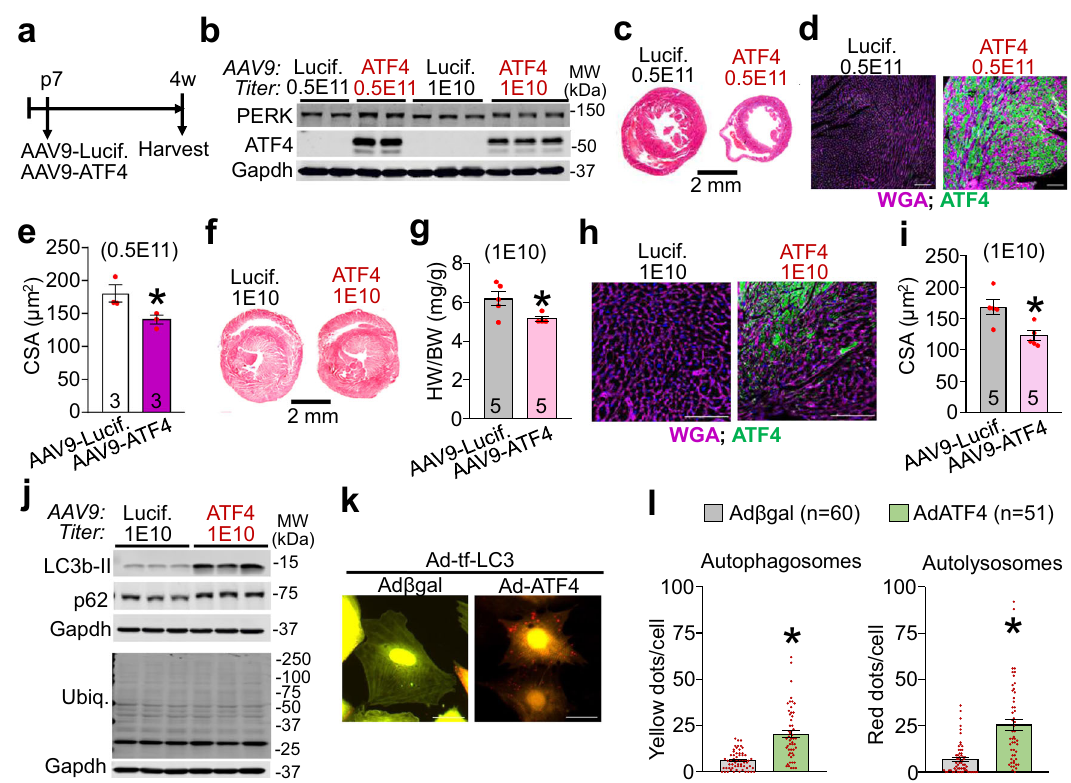
Fig. 9 ATF4 is suf fi cient to induce cardiac atrophy. a Schematic diagram depicting the experimental protocol. Either 0.5E11 or 1E10 genomic copies (gc) of AAV9-ATF4 or AAV9-Lucif. control were injected into the mediastinum of 7-day-old wild-type mouse pups. Hearts were harvested at 4 weeks of age for further analysis. b Representative western blots for PERK and ATF4 from cardiac protein extracts of 4-week-old mice treated with the indicated AAV9. Gapdh serves as a loading control. c , d Representative heart sections with Masson ’ s Trichrome staining ( c ) and immunohistochemistry for ATF4 (green) and WGA (purple)-stained membranes and nuclei with DAPI (blue) ( d ) of AAV9-ATF4 or AAV9-Lucif. injected mice (both 0.5E11 gc) at 4 weeks of age. Scale bars are 2 mm and 100 μ m, respectively. e CSA of AAV9-Lucif. versus AAV9-ATF4 positive cardiomyocytes determined by ATF4 and WGA staining of histological sections as shown in panel “ d ” . * P = 0.0548 vs AAV9-Lucif. f Representative Masson ’ s trichrome stained images of hearts from mice injected with 1E10 gc AAV9-Lucif or -ATF4 and harvested at 4 weeks of age. Scale bar is 2 mm. g HW/BW ratio at 4 weeks of age in the indicated groups of mice. * P = 0.0235 vs AAV9-Lucif. h Representative immunohistochemistry for ATF4 (green), nuclei with DAPI (blue) and WGA (purple)-stained membranes from heart sections of AAV9-ATF4 or AAV9-Lucif. injected mice (both 1E10 gc) at 4 weeks of age. Scale bars are 100 μ m. i CSA of ATF4 positive cardiomyocytes determined by ATF4 and WGA staining as shown in panel “ h ” . * P = 0.0116 vs AAV9-Lucif. j Representative western blots for LC3b, p62, and ubiquitin-conjugated proteins (Ubiq.) from cardiac protein extracts of 4-week-old mice treated with 1E10 gc AAV9-Lucif. or -ATF4. Gapdh serves as a loading control. k , l Representative micrographs of fl uorescent LC3 puncta ( k ) and quanti fi cation thereof ( l ) in cultured primary neonatal rat ventricular myocytes 48 h after infection with adenoviruses to overexpress tandem mRFP-GFP-LC3 (Ad-tf-LC3) and ATF4 or β gal expressing control. Yellow dots represent autophagosomes, whereas red dots indicate autolysosomes. Scale bars are 50 μ m. * P < 0.0001 vs Ad β gal. Number of biologically independent animals or cells analyzed is indicated in each panel. All statistical analysis were performed using two-tailed Student ’ s t test. Error bars are ±standard error of the mean. Source data are provided as a Source Data